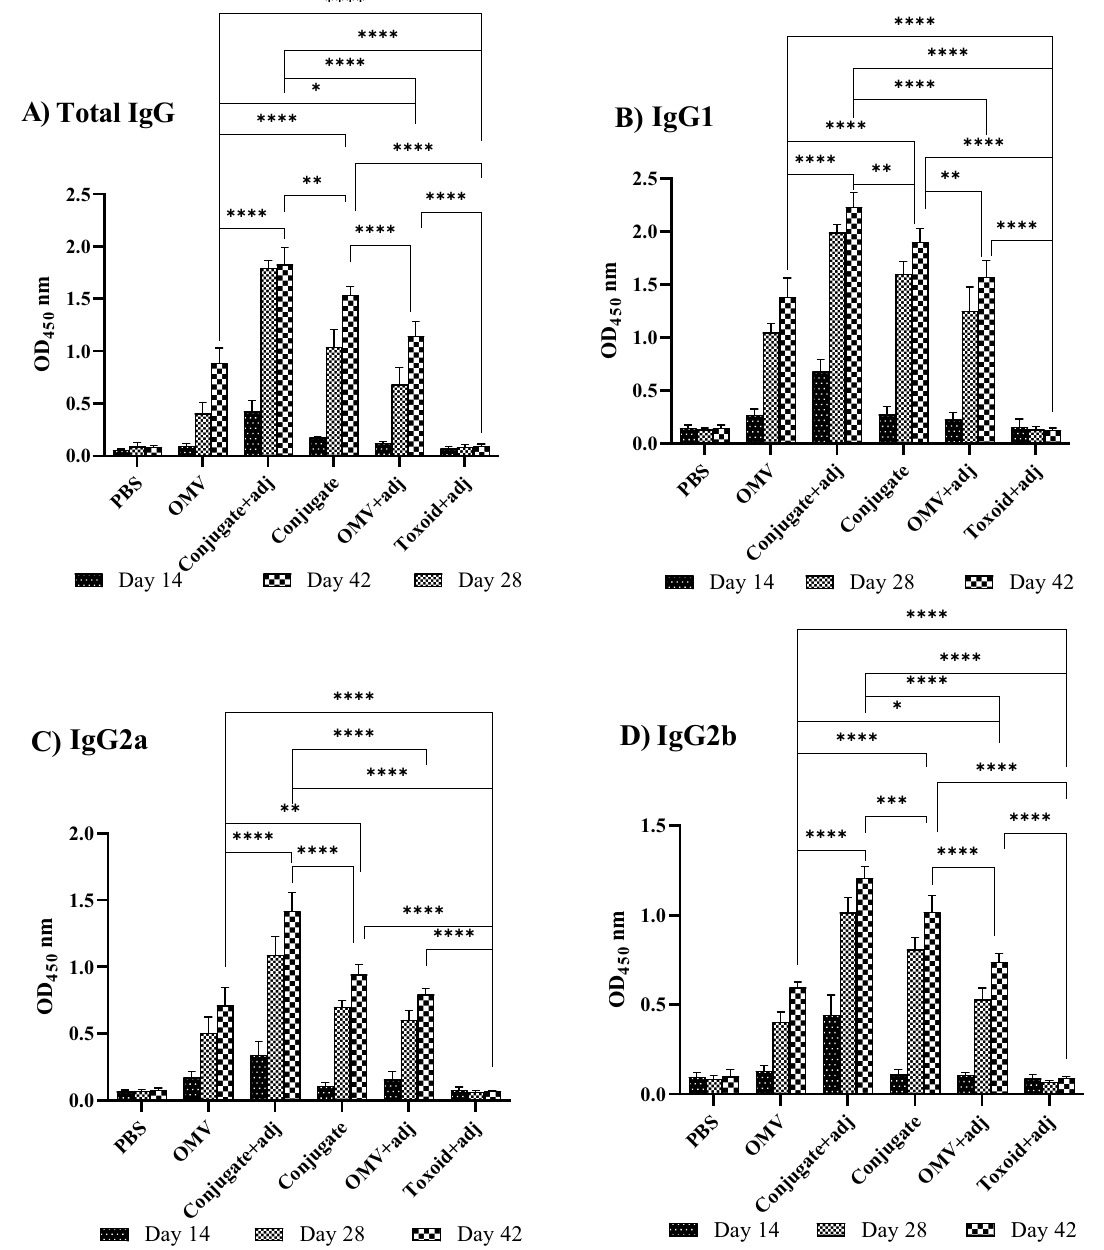
Figure 6. Enzyme-linked immunosorbent assay of IgGs levels raised to antigens. The immunization of mice (n = 5) enhanced the production of specific IgG and subtypes IgG1, IgG2a, and IgG2b responses. ( A ) Specific IgGs levels in immunized groups on days 14, 28, and 42 determined by ELISA. The level of the different IgG subtypes, IgG1 ( B ), IgG2a ( C ), and IgG2b ( D ), were measured from serum samples on days 14, 28, and 42. Data were presented as mean ± S.D. The difference among groups was compared using the two-way ANOVA. * P < 0.05, ** P < 0.01, *** P < 0.001, and **** P < 0.0001 were considered statistically significant,